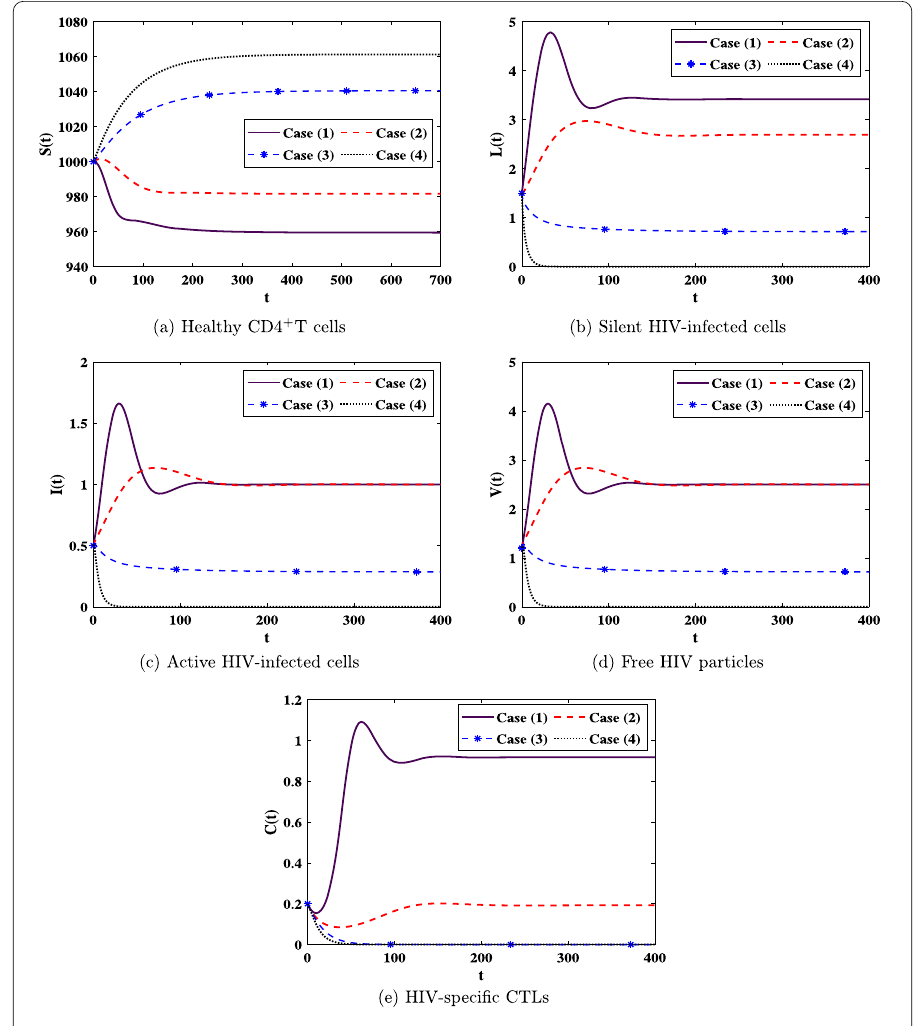
Figure 2 The evolution of HIV dynamics (28) under different modes of transmission